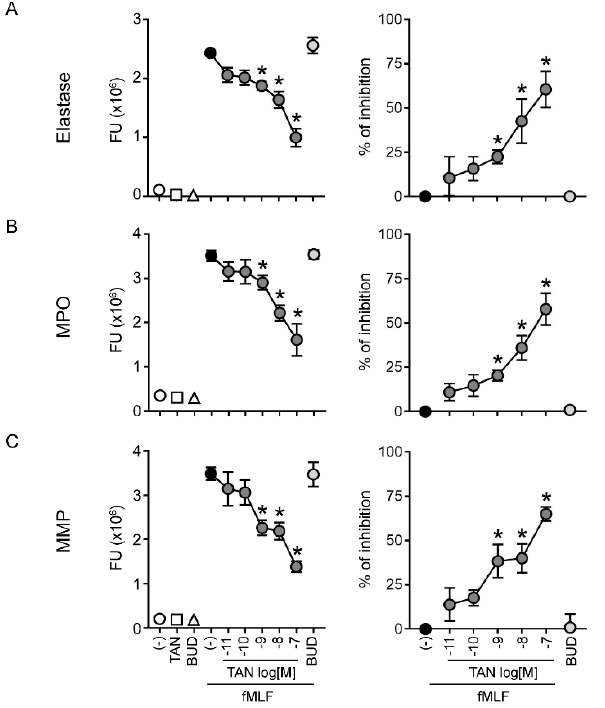
Figure 2. Tanimilast reduces neutrophil degranulation induced by fMLF. Human neutrophils were incubated with vehicle ( − ), tanimilast (TAN) at 10 − 7 M or as indicated, and budesonide (BUD) at 10 − 7 M. Degranulation was induced by fMLF treatment (2 × 10 − 8 M) in the presence of cytochalasin B. Granule protein release was assessed by measuring enzyme activities in cell-free supernatants, using elastase-specific ( A ), MPO-specific ( B ), or MMP-specific ( C ) fluorogenic substrates. Left panels show the fluorimetric readout (FU, Fluorimetic Unit) of each specific enzymatic activity in the cell supernatants, while right panels depict the calculated percentage of inhibition by tanimilast and budesonide. * p < 0.05 One-way ANOVA followed by post hoc test or One-sample t -test ( n = 5). In the same experimental settings, budesonide did not inhibit granule protein